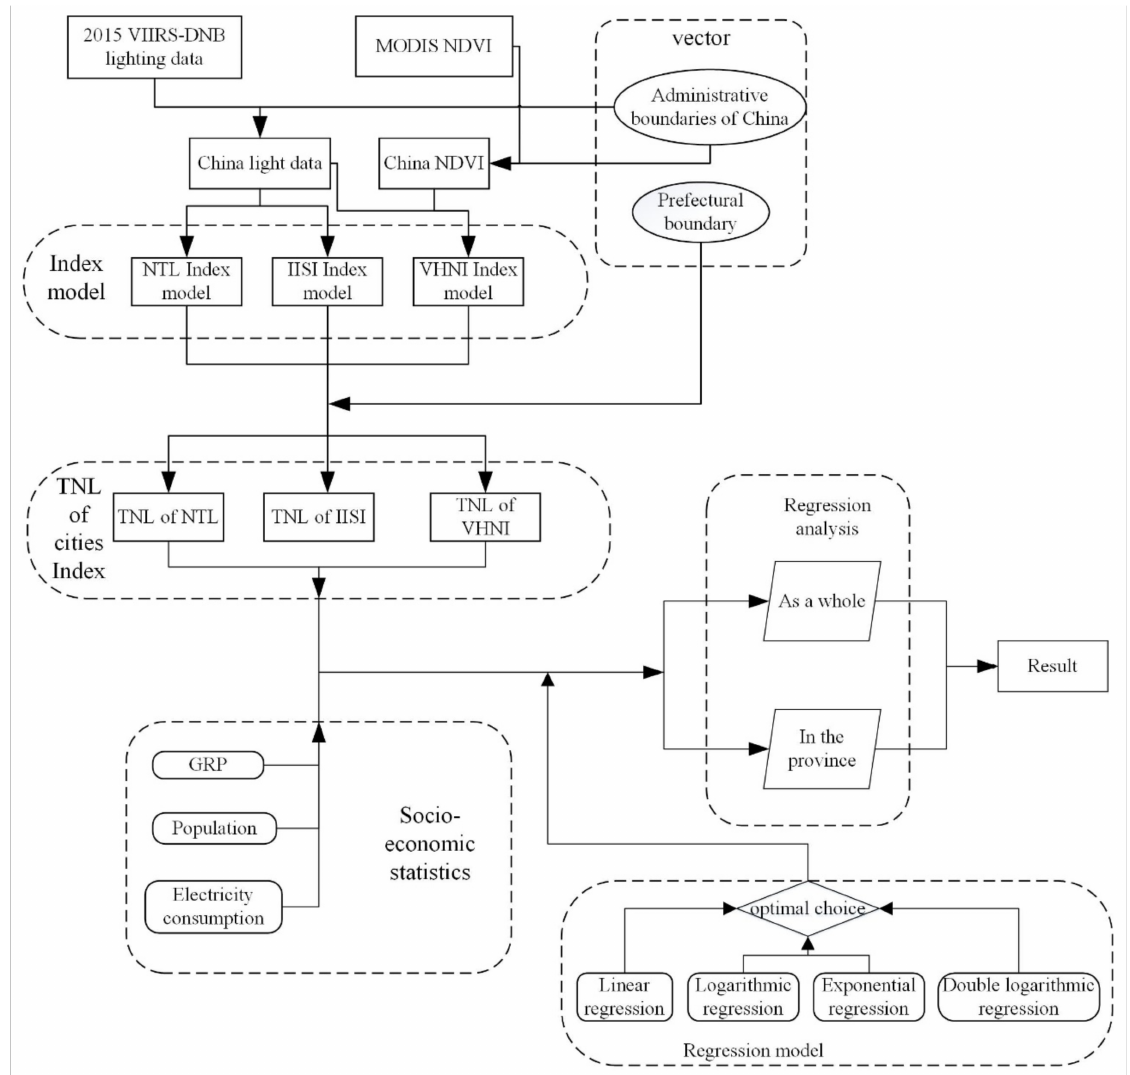
Figure 2. Flowchart. Comparison of regression analysis between different models and three economic